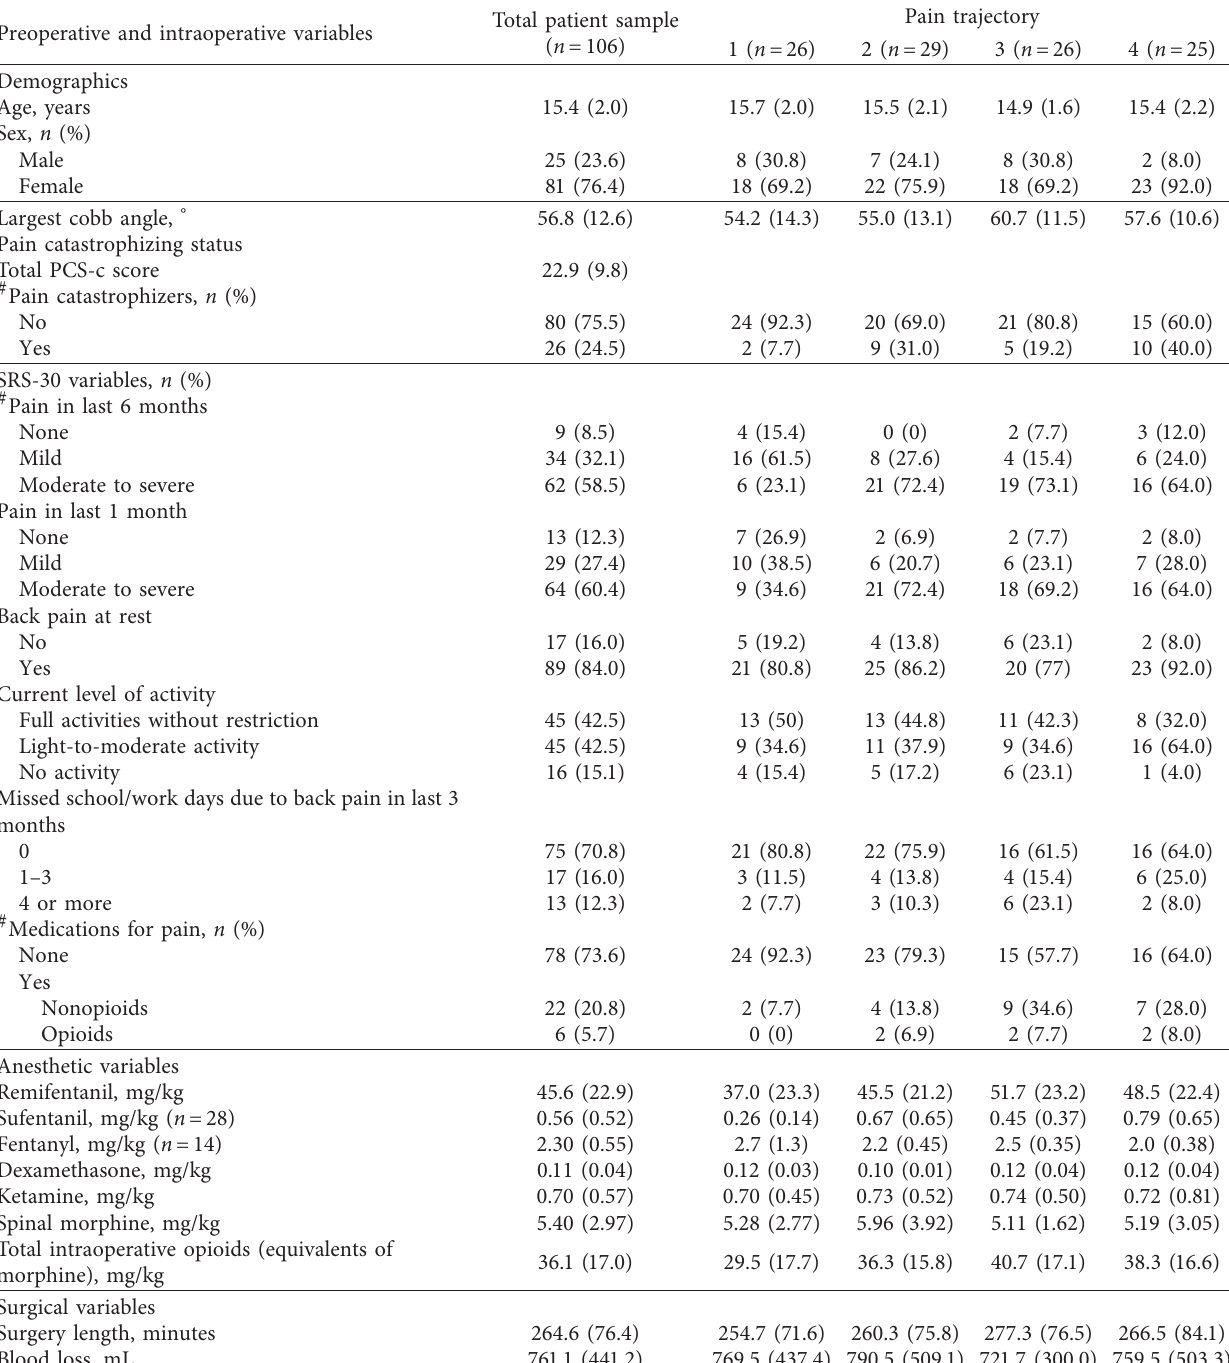
Table 1: Preoperative and intraoperative variables of study patients ( n �